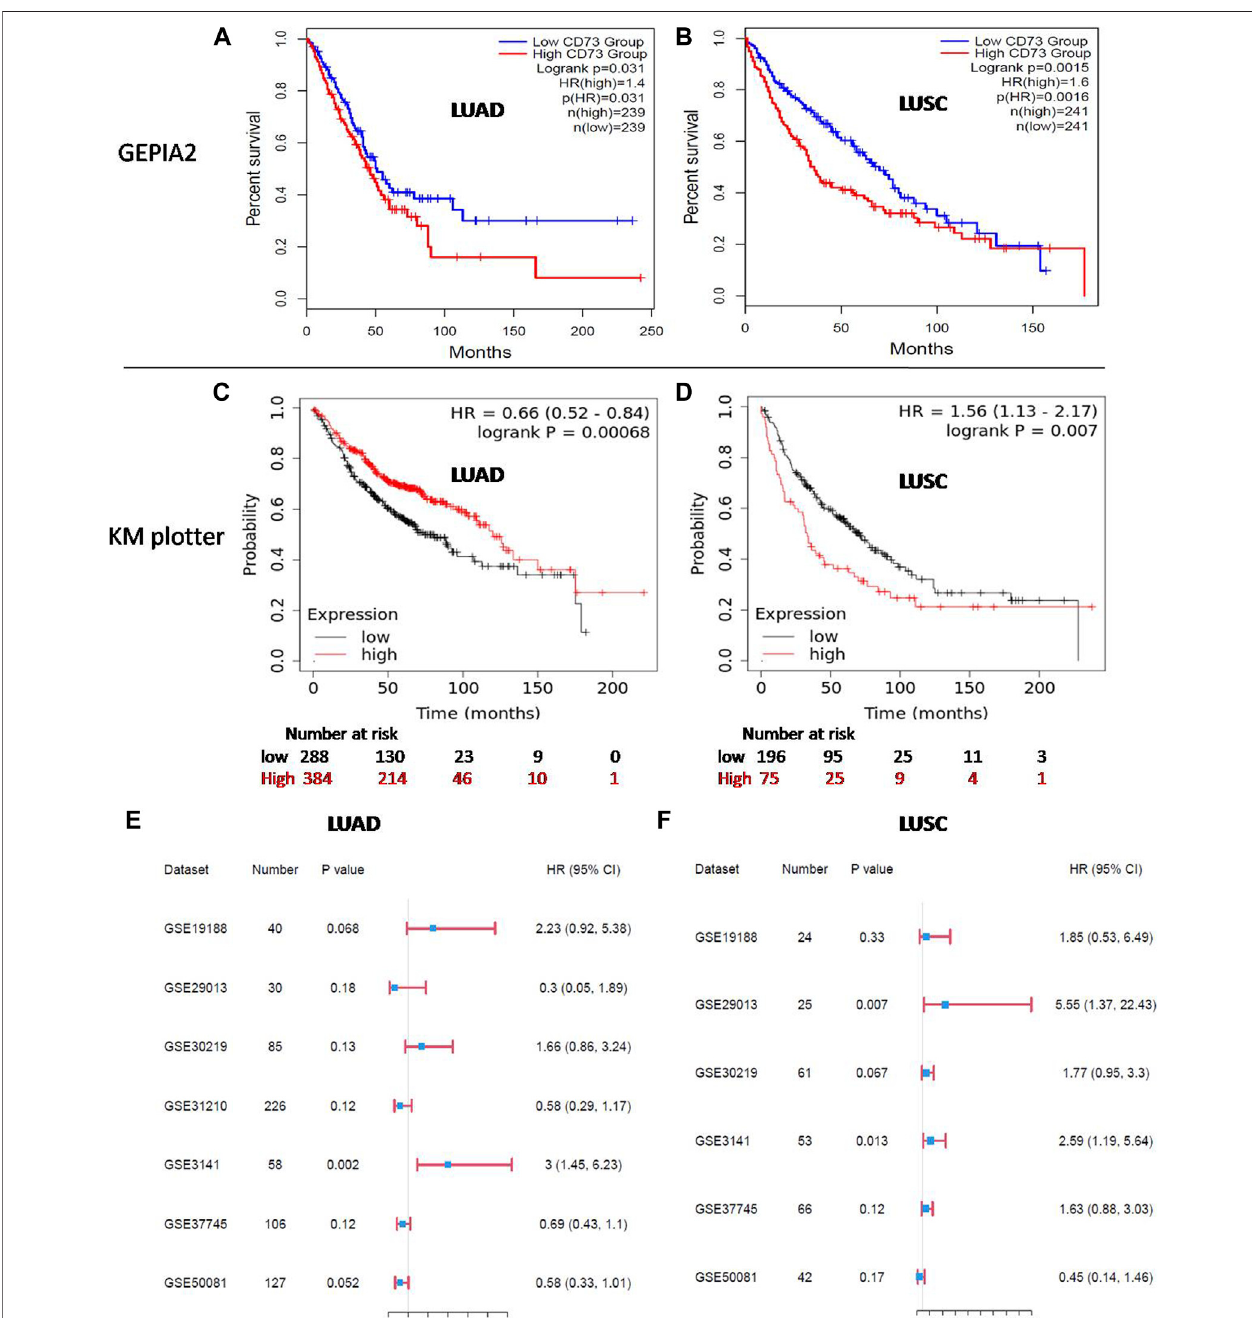
FIGURE2| PrognosisofCD73inLUADandLUSC. (A,B) Kaplan-Meier(KM)survivalanalysisofCD73inLUADandLUSCviaGEPIA2. (C,D) KMsurvivalanalysisof CD73 in LUAD and LUSC via KM plotter. (E) Forest plots showed the relation between CD73 expression and LUAD patients OS in different GEO datasets. (F) Forest plots showed the relation between CD73 expression and LUSC patients OS in different GEO datasets.